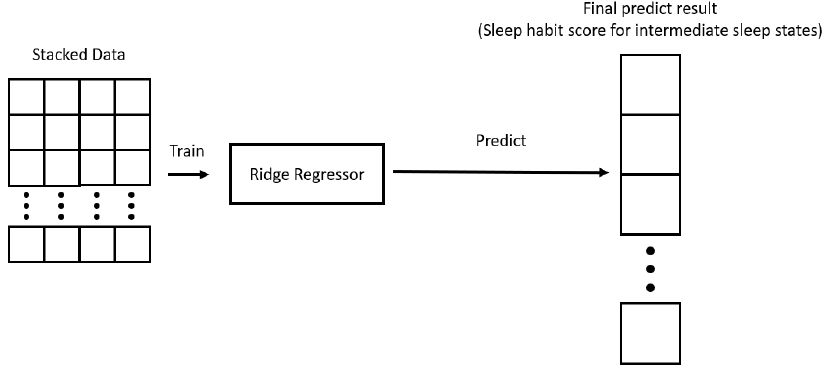
Figure 6. Summary graph for the final stage of the stacking method: in this step, a sleep habit score is calculated for the intermediate sleep state.